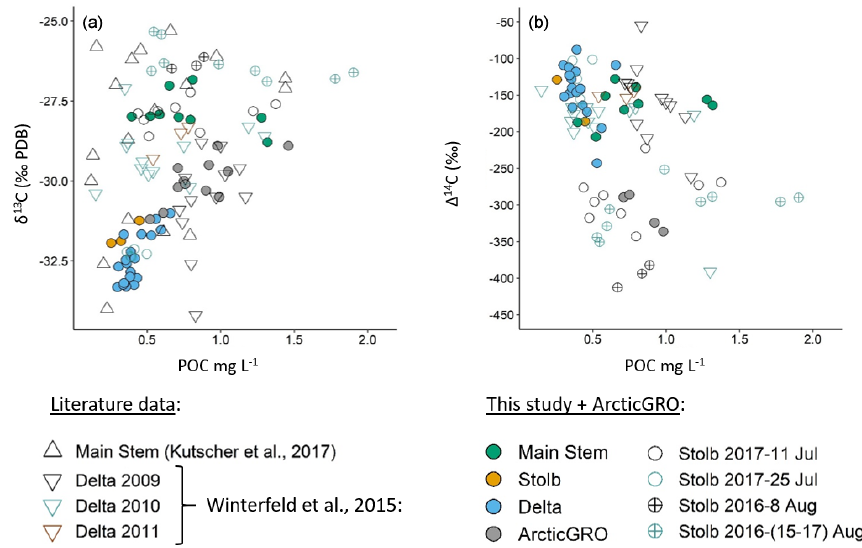
Figure 3. Stable and radiocarbon isotopic values and POC concentration for the Lena delta and the Lena River main stem. Values were taken from this study and from the literature (Kutscher et al., 2017; Winterfeld et al.,